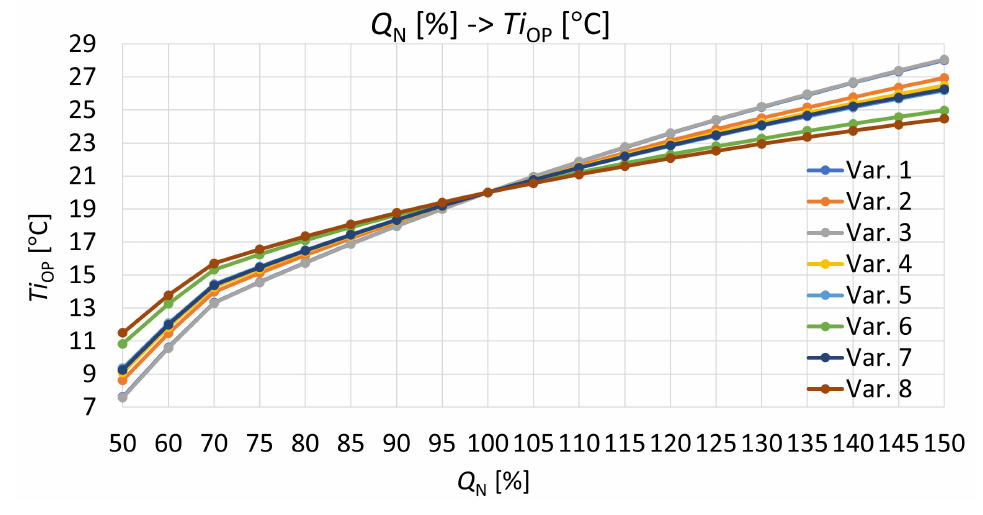
Figure 1. Calculated value Q